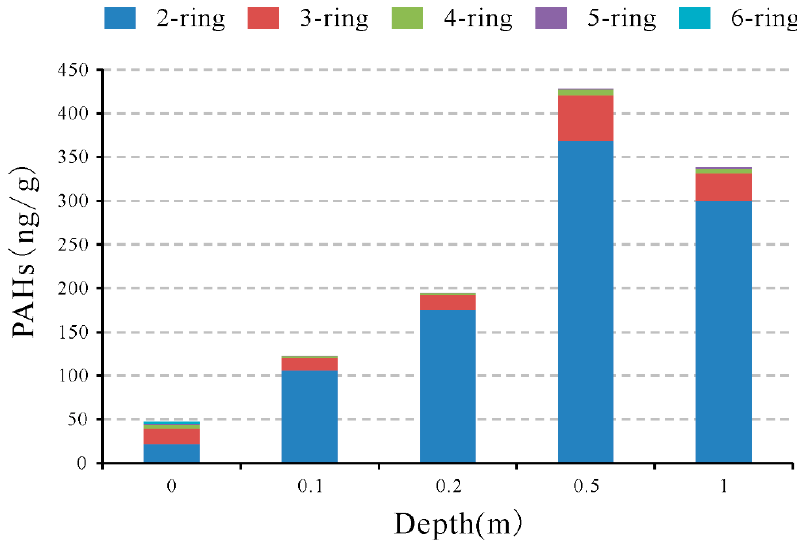
Figure 6. Concentration of PAHs vs. depth in the underground soils from borehole B2, according to ring number.